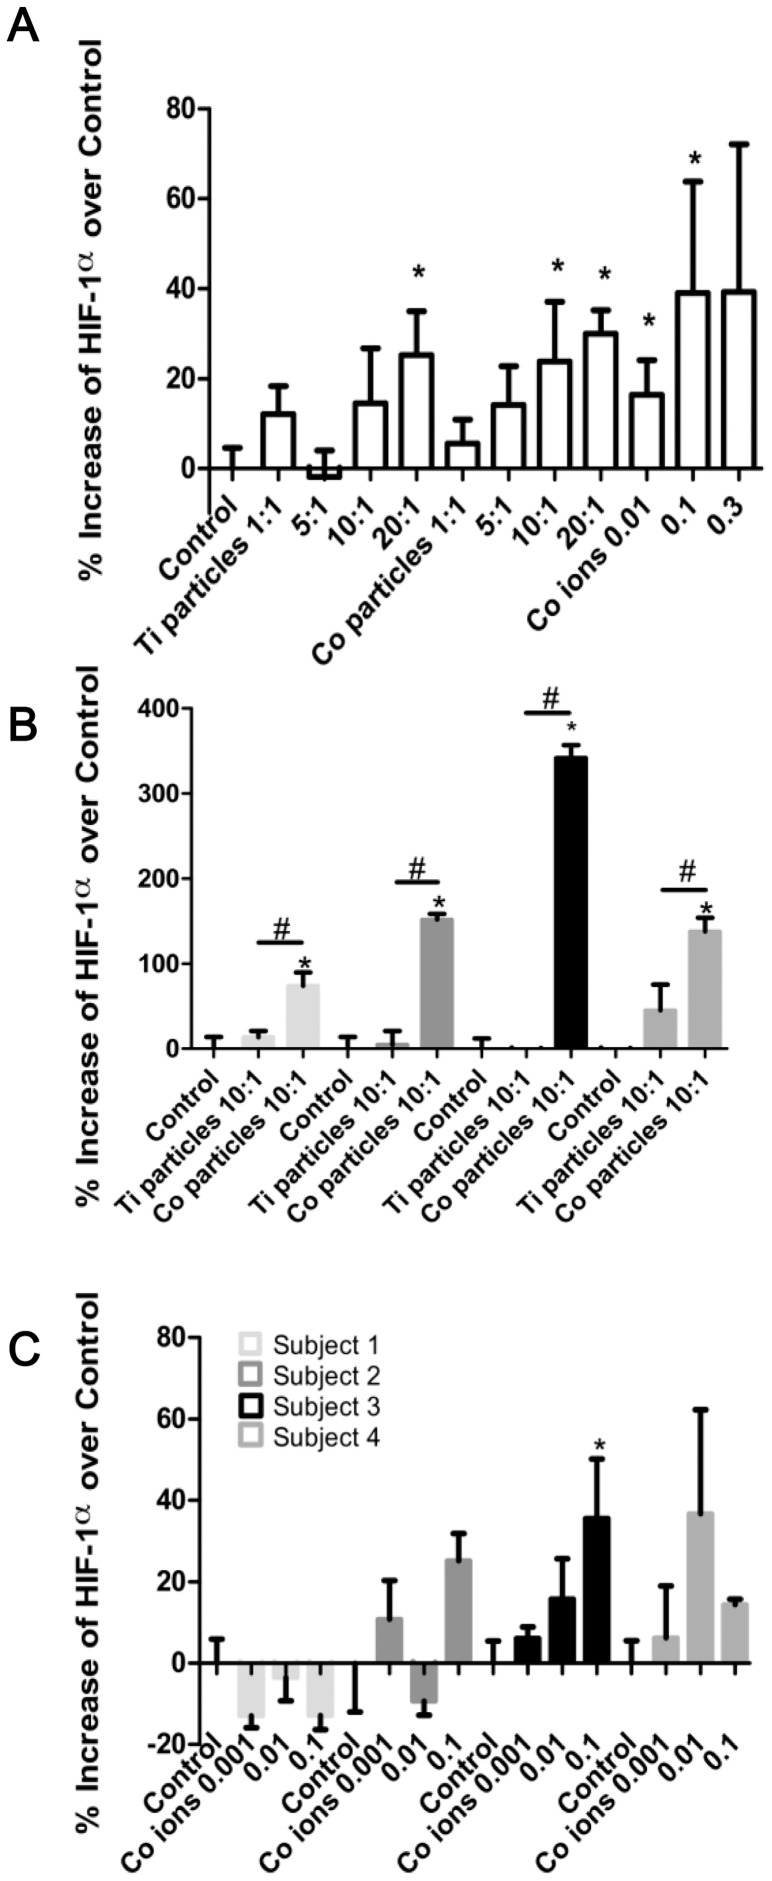
Total HIF-1α protein expression in vitro.(A) THP-1 macrophages (80,000cells/well) were cultured with increasing ratios of Ti-alloy and Co-alloy particles to cells (from 1/1, 5/1, 10/1, 20/1 particles/cell) or to increasing concentrations of CoCl2 for 6 hrs (0.01–0.3 mM). HIF-1α protein levels were determined using Total HIF-1α Cell-Based ELISA kit. Averages of challenged cells were normalized to unchallenged control cells and represented as the percentage increase of HIF-1α expression in comparison to unchallenged control cells. (B–C) Human primary macrophages (n = 4) were cultured with Ti-alloy and Co-alloy particles at a 10∶1 (particles∶cell) ratio for 6 hours (B) and with increasing concentrations of CoCl2 for 16 hours at 0.001–0.1 mM CoCl2 (C). HIF-1α protein levels were determined using Total HIF-1α Cell-Based ELISA kit. Averages of challenged cells were normalized to unchallenged control cells and represented as the percentage increase of HIF-1α expression in comparison to unchallenged control cells. Note: *p<0.05, determined by Student's t-test, # p<0.05 ANOVA.